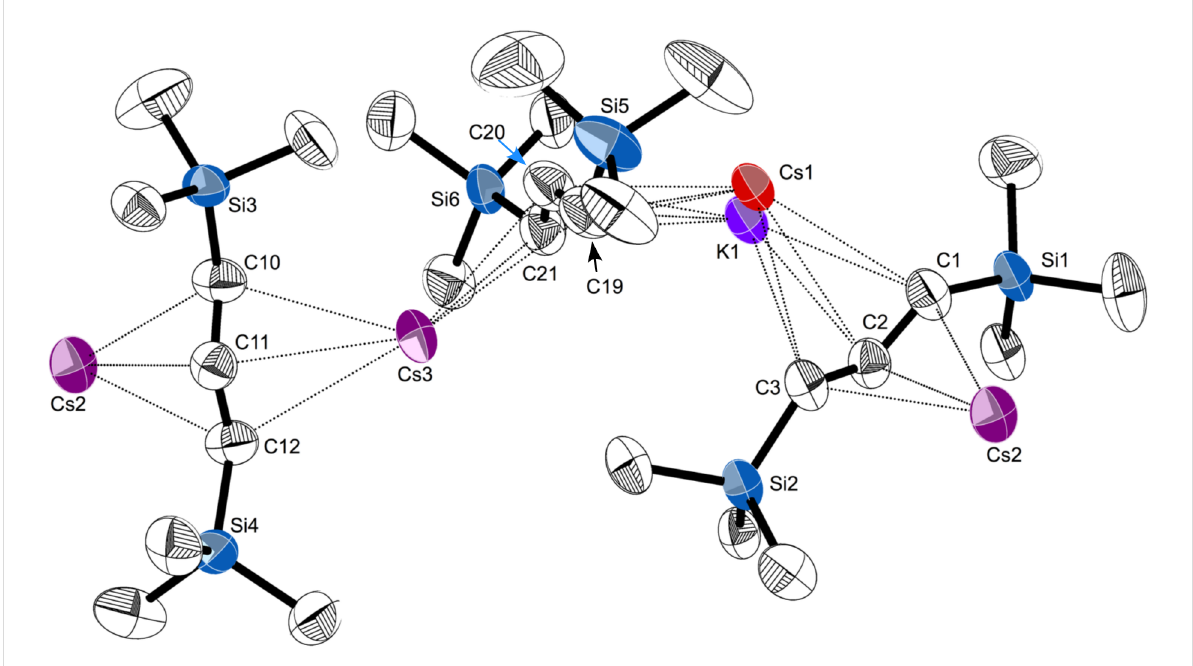
Figure 1: Portion of the polymeric chain of [CsKA' 2 ], with thermal ellipsoids drawn at the 50% level. Hydrogen atoms have been removed for clarity. Atoms marked “Cs2” and “Cs3” are site disorders of Cs and K, with relative occupancies of 0.29:0.71 and 0.61:0.39, respectively. Selected distances (Å) and angles (deg): Cs2–C1, 3.099(4); Cs2–C2, 3.058(4); Cs2–C3, 3.198(4); Cs2–C10, 3.072(4); Cs2–C11, 2.990(4); Cs2–C12, 3.066(4); Cs1–C1, 3.242(4); Cs1–C2, 3.329(4); Cs1–C3, 3.562(4); K1–C1, 3.135(5); K1–C2, 3.026(5); Cs1–C19, 3.149(5); Cs1–C20, 3.197(4); Cs1–C21,